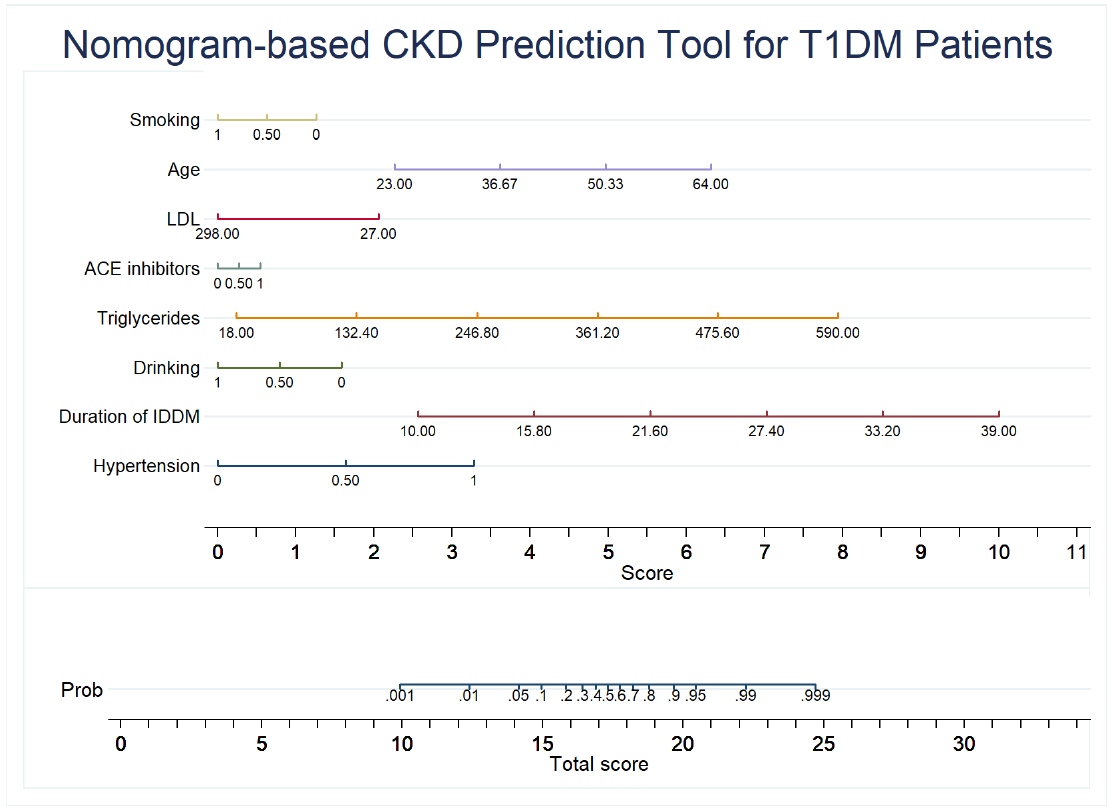
Figure 6. Nomogram to predict the likelihood of CKD in T1DM patients.